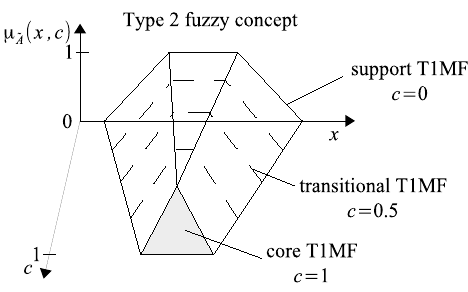
( x , c ) of T2F-set ˜ A with 5 transitional T1MFs of various A